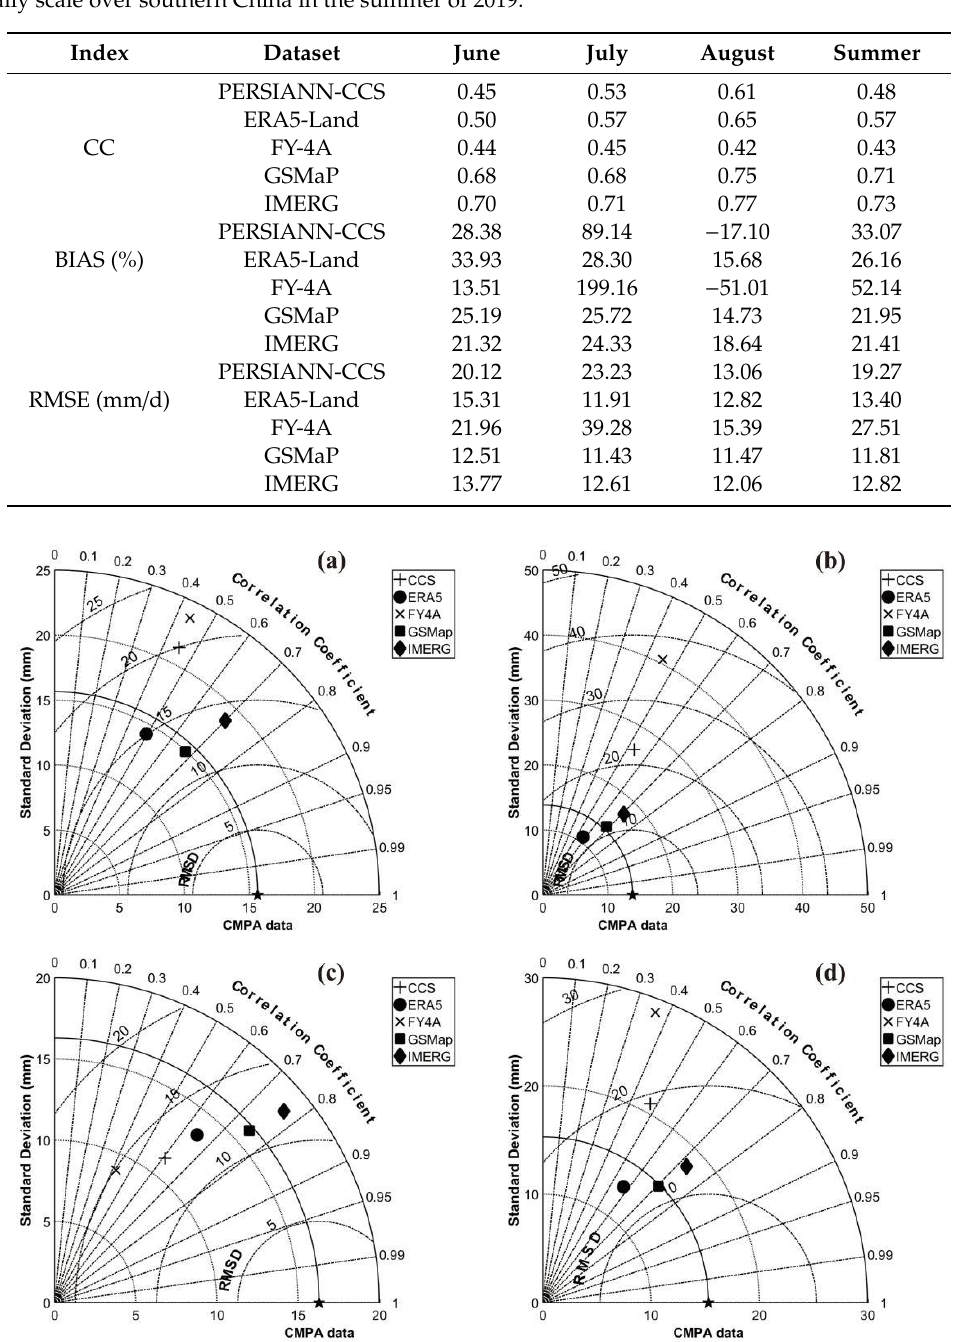
Table 4. Summaries of the results for PERSIANN-CCS, ERA5-Land, FY-4A, GSMaP, and IMERG at a daily scale over southern China in the summer of 2019.